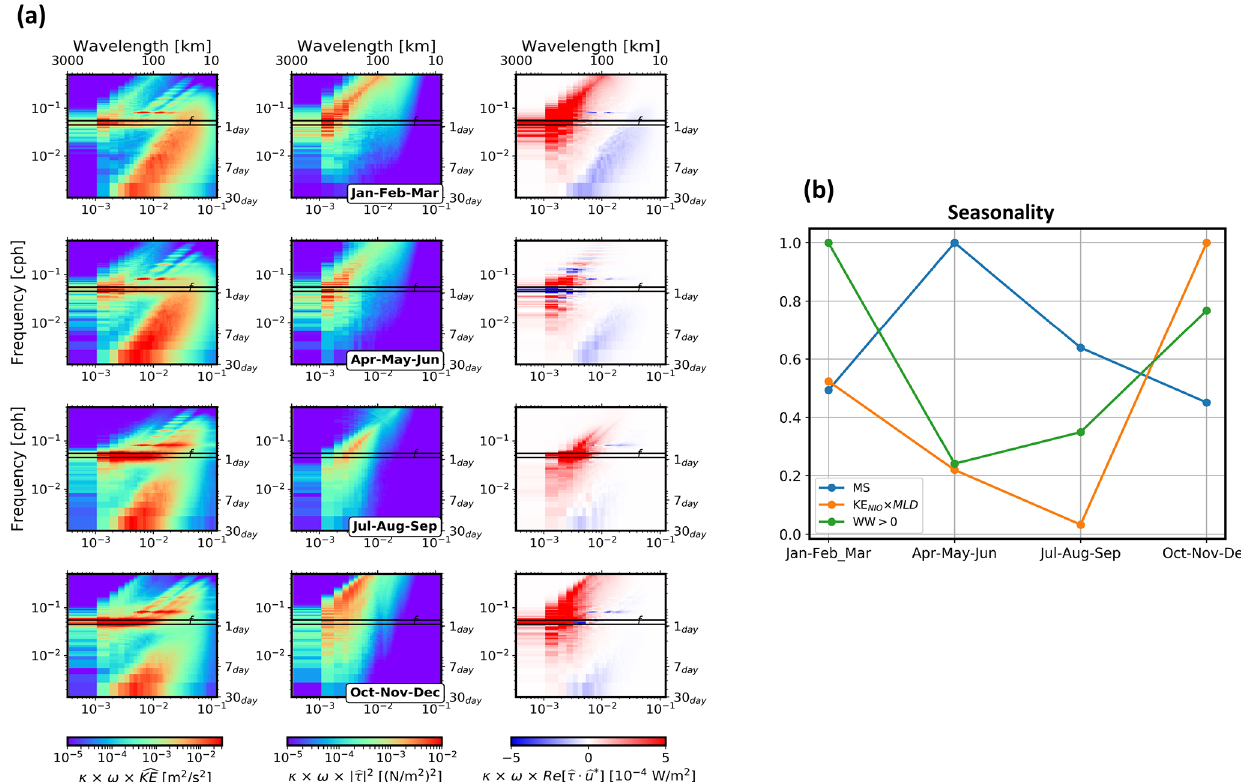
Figure 6. (a) Seasonal variability of the frequency-wavenumber spectra of surface current (first column), wind stress (middle column), and co-spectrum of the wind work (third column). (b) Seasonal variability of kinetic energy associated with mesoscale motions, MS (defined by 350km > L > 30km and periods 30d > T > 5d, blue curve), kinetic energy of near-inertial motions times the mixed layer depth (orange curve), and positive wind work (green curve). The variance has been integrated then normalized to its maximum